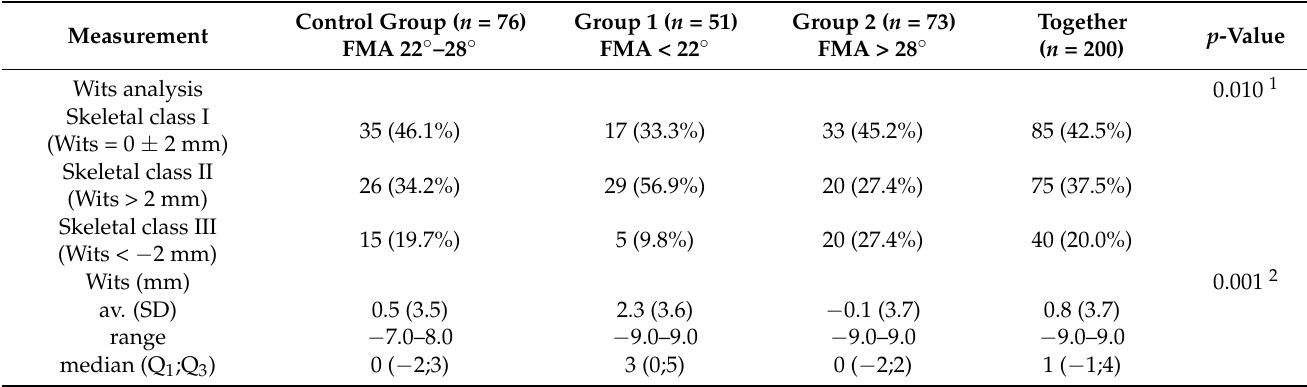
Table 4. Wits analysis among the examined groups.